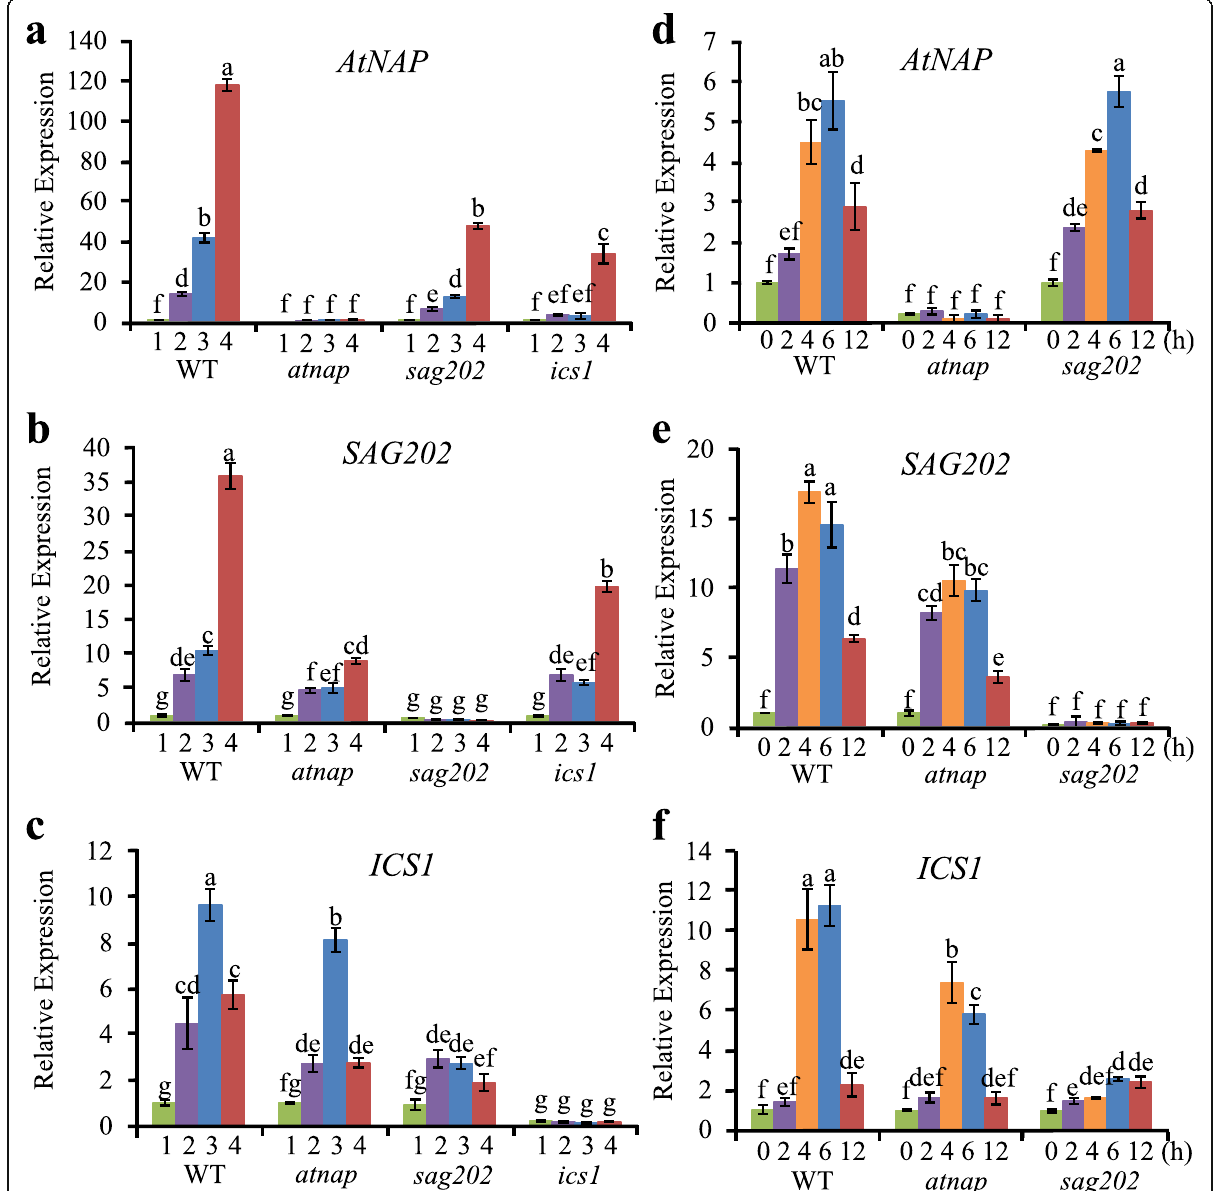
Fig. 5 qPCR analyses of transcript levels of AtNAP , SAG202 , and ICS1 in different mutants during senescence or after SA treatment. ( a - c ) Transcript levels of AtNAP , SAG202 and ICS1 in leaves of WT, atnap , sag202 and ics1 null mutants at different senescence stages (1, NS; 2, ES; 3, MS; 4, LS as described in legend to Fig. 1a). ( d - f ) Transcript levels of AtNAP , SAG202 and ICS1 in NS leaves of WT, atnap and sag202 null mutants at time points after treatment with 5 mM SA. Relative expression levels were calculated and normalized with respect to Actin 2 ( ACT2 ) transcripts. Error bars indicate SD of three biological repeats. Significant ( P < 0.05) differences between means are indicated by different letters using Tukey ’ s HSD